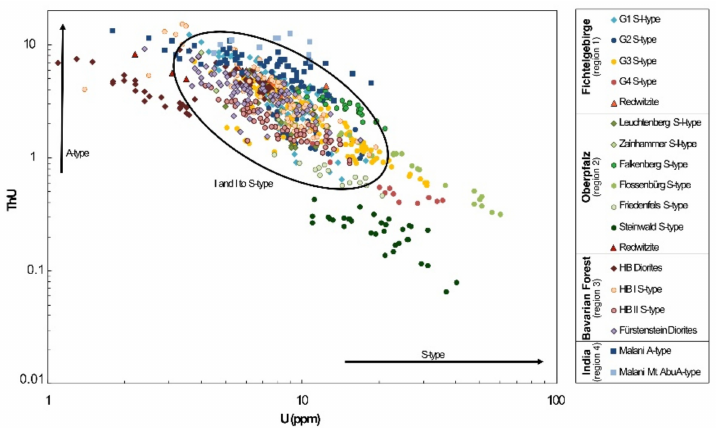
Figure 10. Th/U versus U for all samples. The samples show a negative line. The A-type granites tend to raise the Th/U ratios. The S-type granites show higher and quite variable U concentrations with lower Th/U